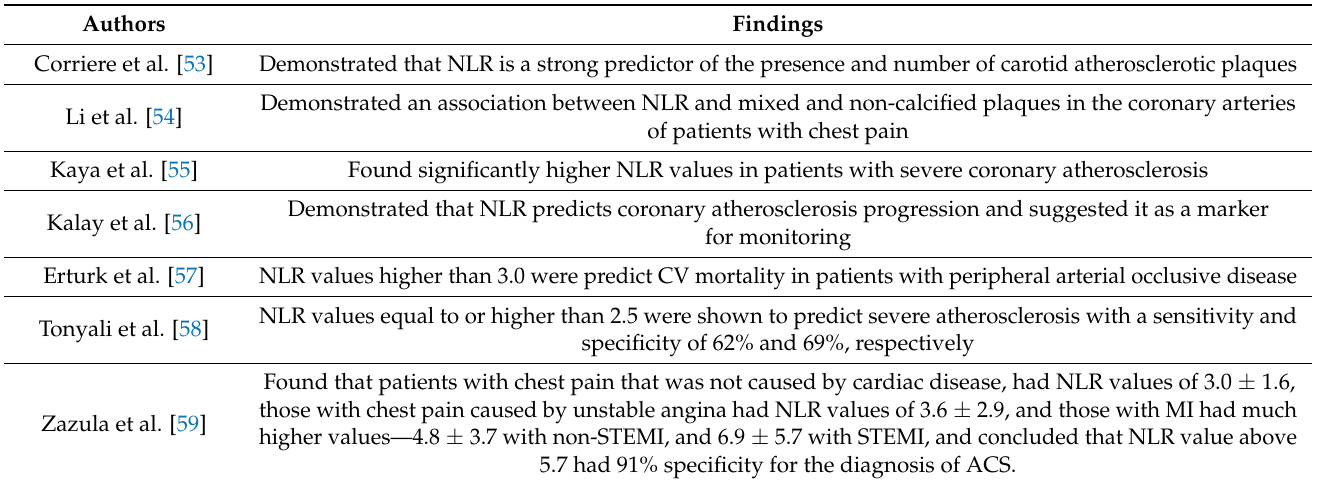
Table 1. Published papers in which neutrophil-to-lymphocyte ratio (NLR) was assessed in the context of atherosclerotic cardiovascular disease (CVD).